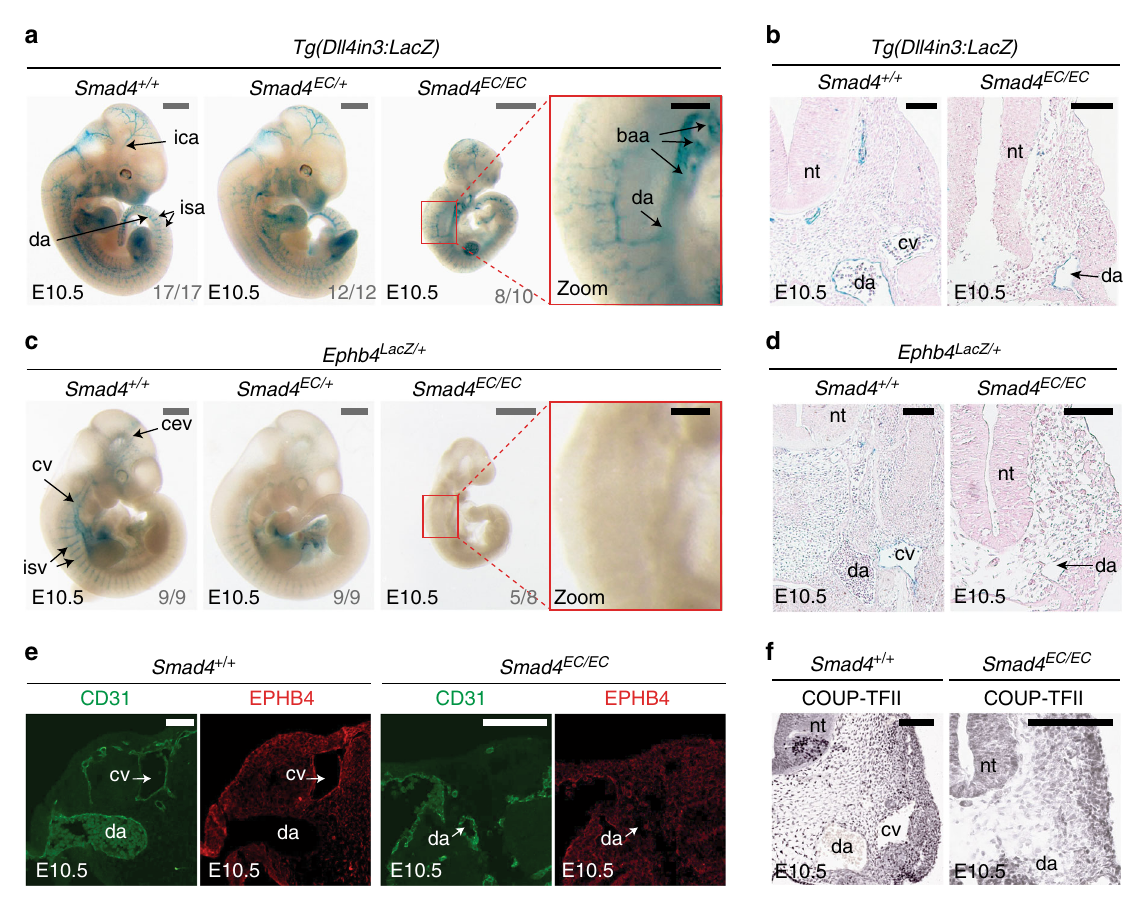
Fig. 1 Endothelial-speci fi c knockout of Smad4 does not affect arterial identity but results in the loss of Ephb4 expression. a , b Representative E10.5 whole- mount images ( a ) and transverse sections ( b ) from wild-type Smad4 + / + ( n = 17), heterozygous Smad4 EC/ + ; ( n = 12) and homozygous Smad4 EC/EC ( n = 10) embryos all expressing the arterial Dll4in3: LacZ transgene ( fi ve litters in total). Robust transgene expression, speci fi c to arterial endothelial cells, was seen in all embryos regardless of Smad4 genotype. Grey scale bars are 500 μ m, black scale bars are 100 μ m. c , d Representative E10.5 whole-mount images ( c ) and transverse sections ( d ) from wild-type Smad4 + / + ( n = 9), heterozygous Smad4 EC/ + ; ( n = 9) and homozygous Smad4 EC/EC ( n = 8) embryos also transgenic for the venous marker Ephb4 LacZ (four litters total). Robust X-gal activity is detected in the veins of Smad4 + / + embryos but is reduced in Smad4 EC/ + embryos and absent in Smad4 EC/EC . Red box denotes zoomed region, grey numbers on bottom right denote the number of embryos similar to picture shown. Grey scale bars are 500 μ m, black scale bars are 100 μ m. Outliers are shown in Supplementary Figure 1e. e , f Expression of the venous endothelial cell markers EPHB4 ( e ) and COUP-TFII ( f ) in transverse sections from E10.5 Smad4 + / + and Smad4 EC/EC embryos. In addition to venous endothelial cells, COUP-TFII is expressed by arterial smooth muscle cells and other mesenchymal cells (as reported by You et al. 7 ). White scale bars are 100 μ m. EC indicates Tie2:Cre-mediated deletion, + / + indicates Cre − , EC/ + indicates Cre + ,Smad4 fl / + and EC/EC indicates Cre + ;Smad4 fl / fl . da = dorsal aorta, ica = internal carotid artery, isa = intersomitic arteries, isv = intersomitic vessel, baa = branchial arch arteries, nt = neural tube, cv = cardinal vein, cev = branches of cerebral venous plexus. See also Supplementary Figure